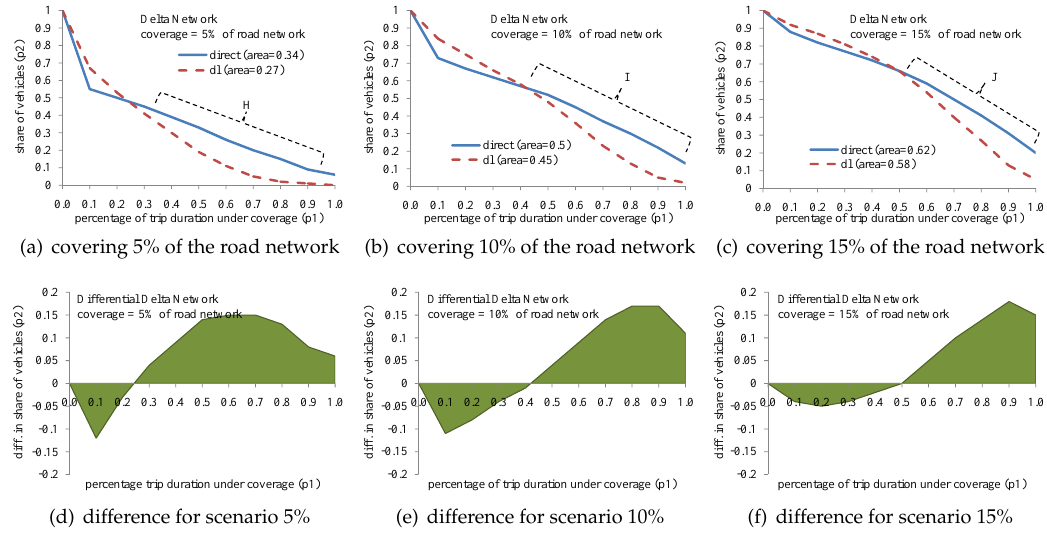
Figure 8. Strategy dl deploys roadside units at the most popular locations (red color), while direct assumes a distribution of weights equal to ρ 1 (color blue). The y -axis indicates the share of vehicles ( ρ 2 ), while the x -axis indicates percentage of trip under coverage ( ρ 1 ). ( a – c ) Consider coverage ranging from 5% up to 15% of the road network. ( d – f ) Represent the difference “ direct minus dl ”.